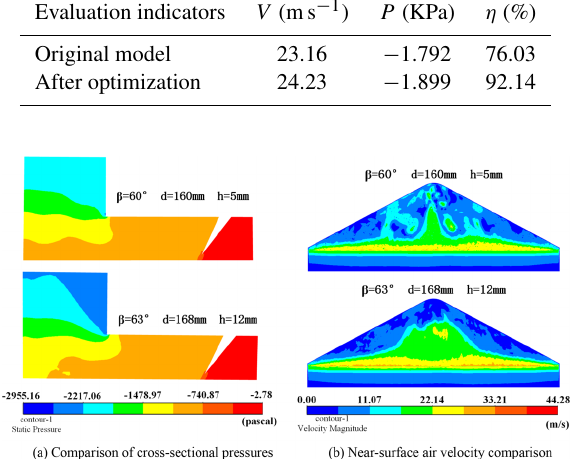
Figure 17. Comparison of flow field characteristics before and after optimization.